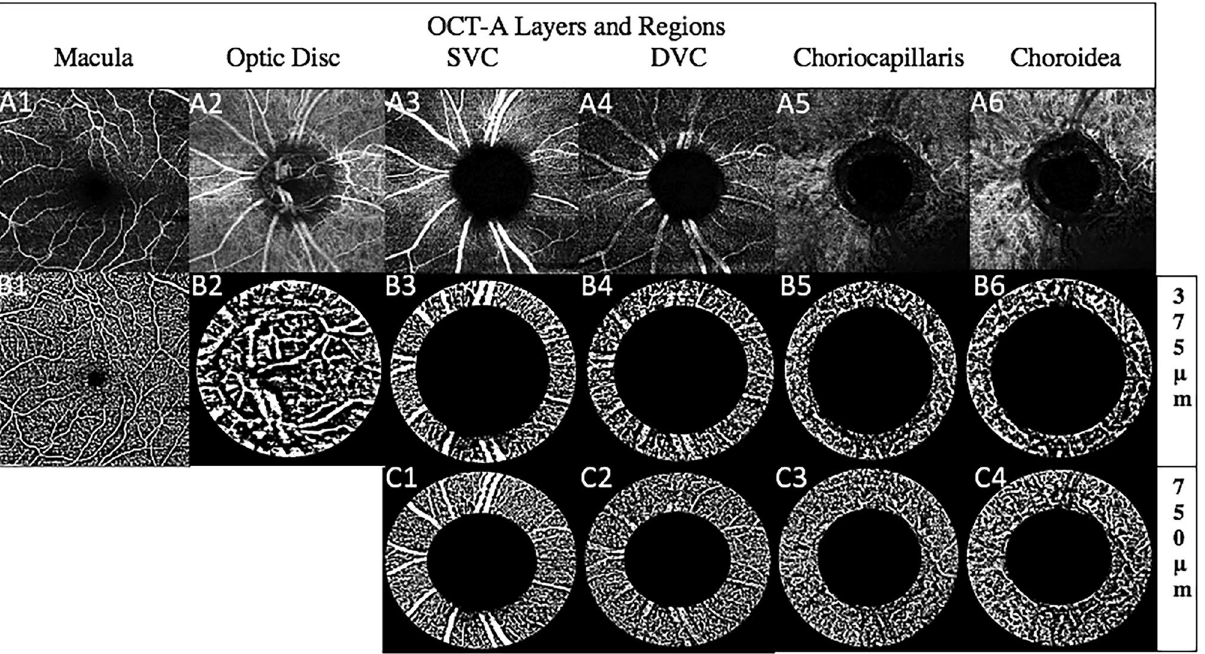
images of the original images (B3-6, 375 μm peripapillary circle and C1-4, 750 μm peripapillary circle).